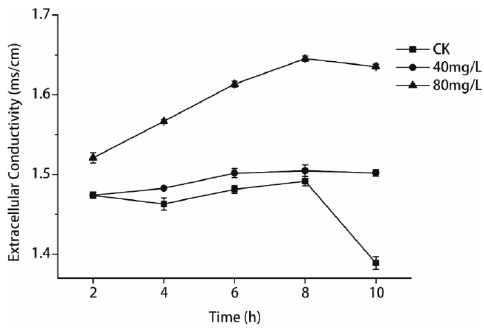
Figure 6. Effects of isoliquiritin on the relative electric conductivity of P. litchii Chen. Values were mean ( n = 3) ± S.E.